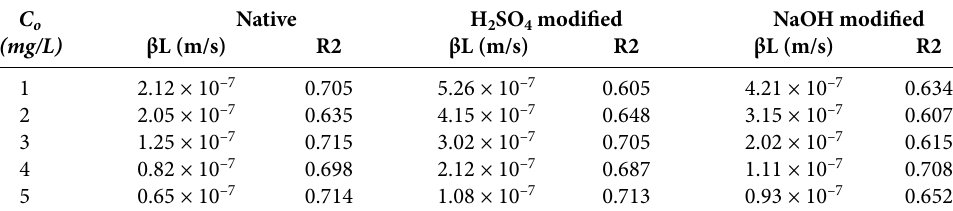
Table 4. Estimated values of mass transfer coefficients (β L ) from McKay et al model C o Native